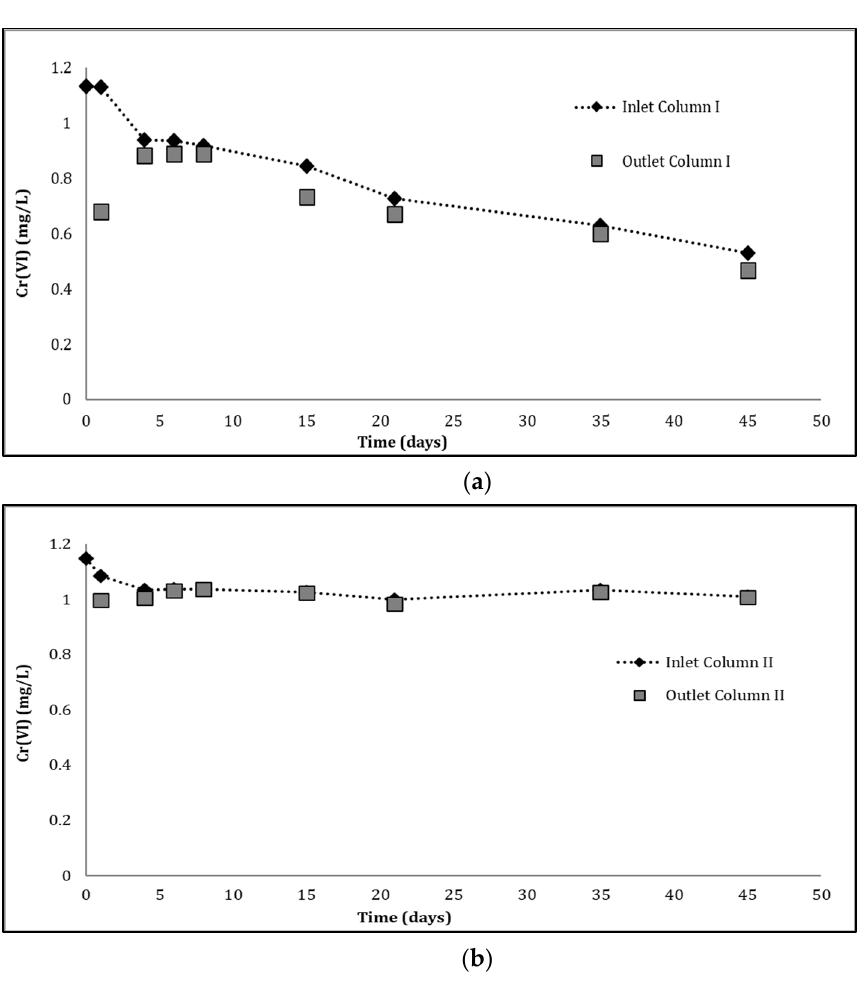
Figure 3. Cr(VI) profiles in the inlet and outlet of Columns I ( a ) and II ( b ) after the addition of ferrous iron.